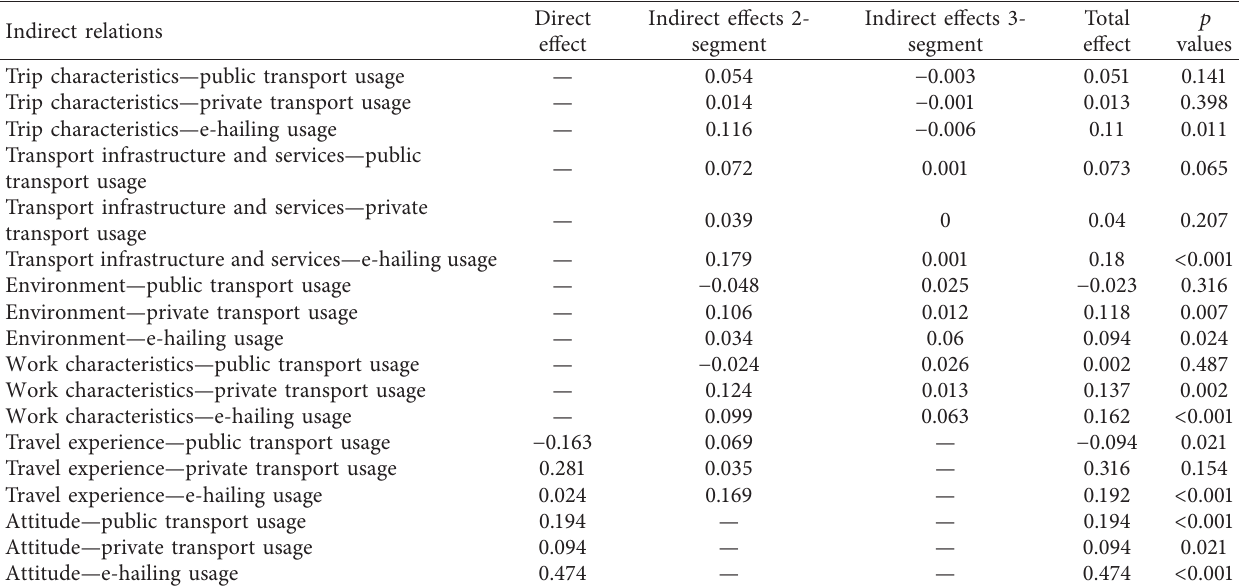
Table 7: The validation of direct, indirect, and total